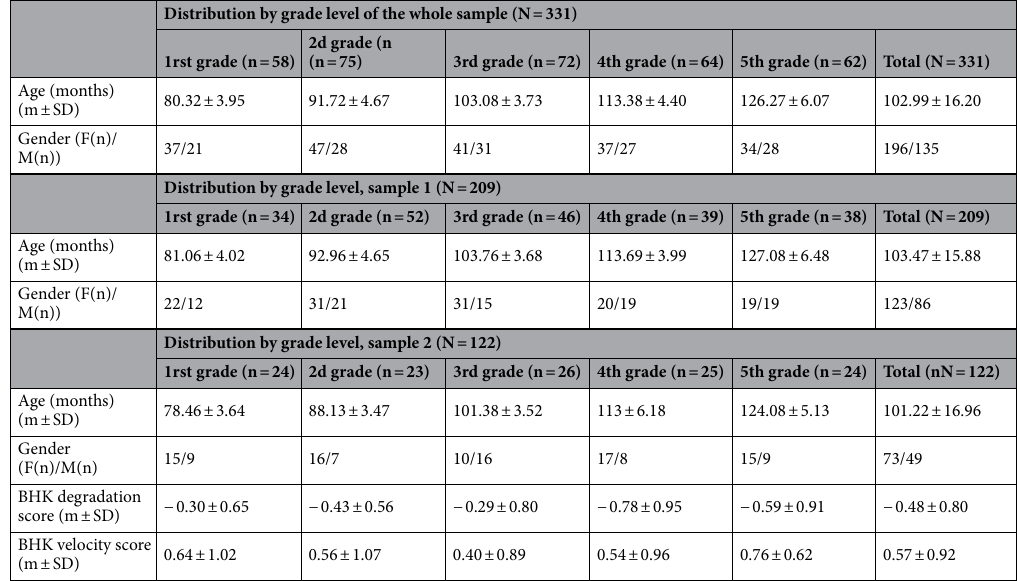
Table 1. Characteristics of the children in the both samples 1 and 2 (N = 331). m mean, SD standard deviation, F female, M male, BHK degradation score the lower the degradation score the better the writing